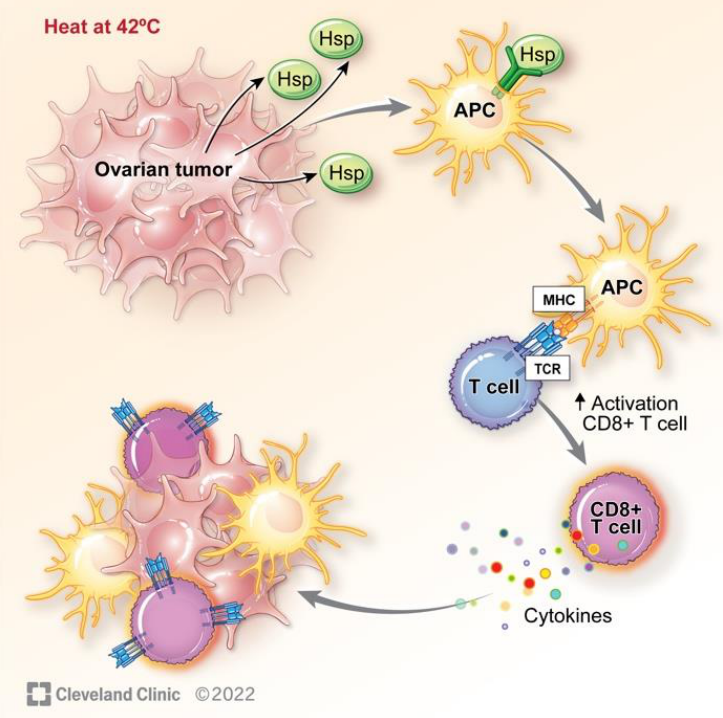
Figure 3. Heat shock protein activation via hyperthermia with downstream cytokine activation, stimulating an immune response. Reprinted with permission, Cleveland Clinic Foundation © 2022.